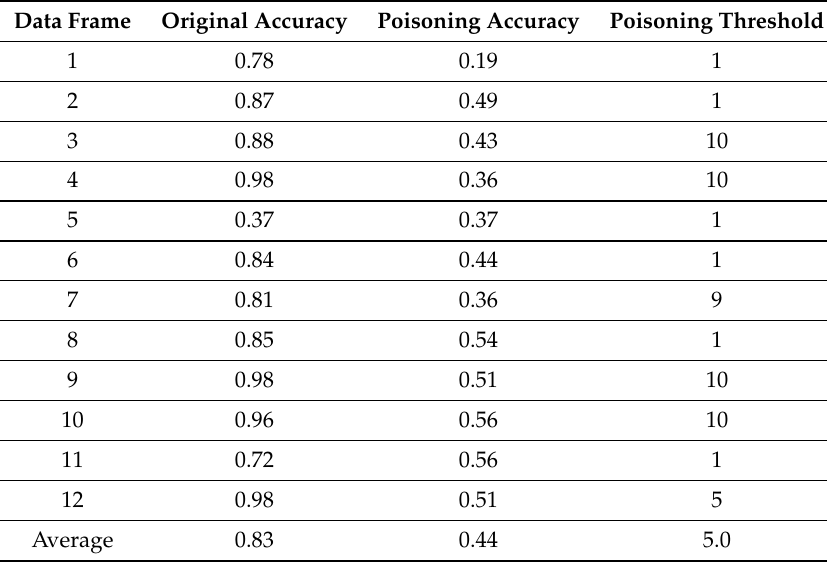
Table 1. Results of Dynamic Relabeling